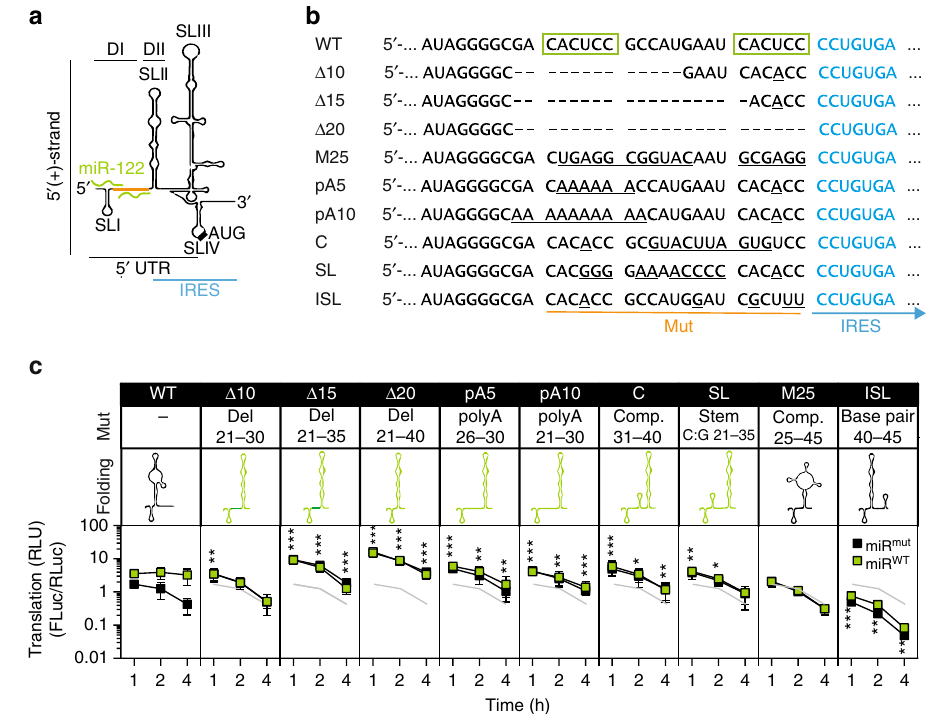
Fig. 4 DI mutants and their in fl uence on translation using the Luc-SG replicon. a Illustration of the HCV 5 ′ UTR and IRES and location of the inserted mutations (orange). b Sequence alterations of DI mutants compared to WT. The miR-122 seed binding sites are marked by green boxes. Note that all mutants lack wild type miR-122 binding, due to mutations in the seed sequence. c Translation assays in Hep3B cells, using fi re fl y luciferase (FLuc) reporter replicons and a capped Renilla (RLuc) control. miR mut or miR WT were co-electroporated, and luciferase activity was measured after 1, 2 and 4 h. All constructs were replication de fi cient Δ GDD mutants, to exclude potential effects of early replication. Mutations are described in the “ mut ” row, and a pictogram of the predicted minimum free energy structure in the “ folding ” row. Mutants enhancing SLII formation are depicted in green, SLII alt stabilizing in red. Mean values (±SD), n = 3, duplicates. RLU relative light units. Statistical signi fi cance of the difference between WT and DI mutants in the presence of miR mut is indicated. The reference graph used to calculate is given in each subpanel in light gray. * P < 0.05, ** P < 0.01, *** P <